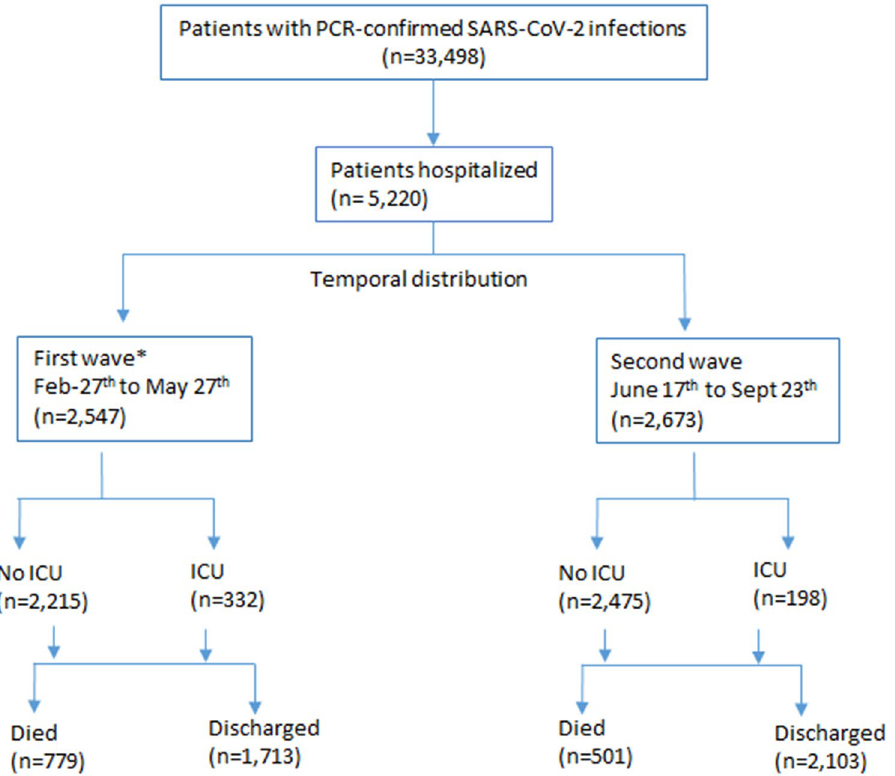
Figure 2. Selection and analysis of study participants in Aragon, Spain, February-September 2020.